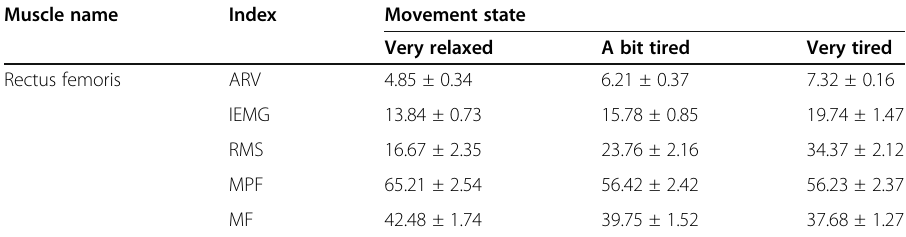
Table 2 Straight femoral electromyography indexes of different exercise states Muscle